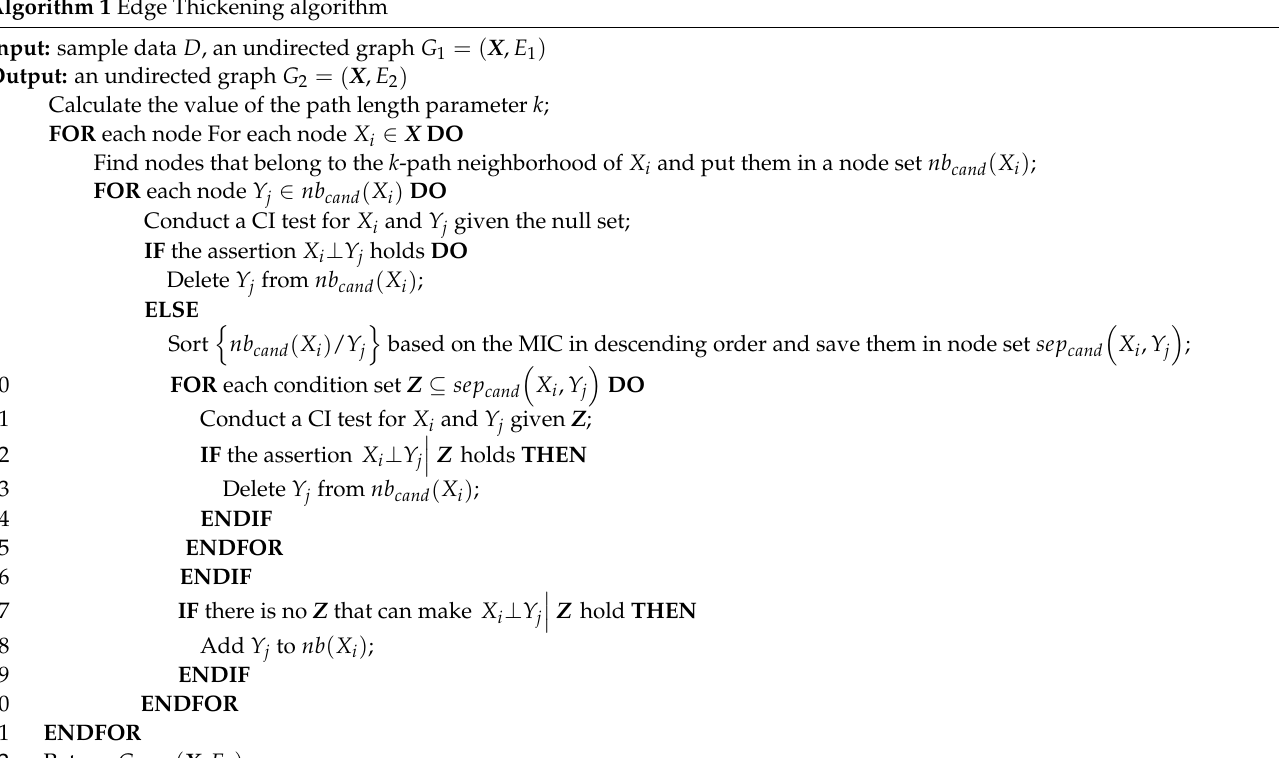
Algorithm 1 Edge Thickening